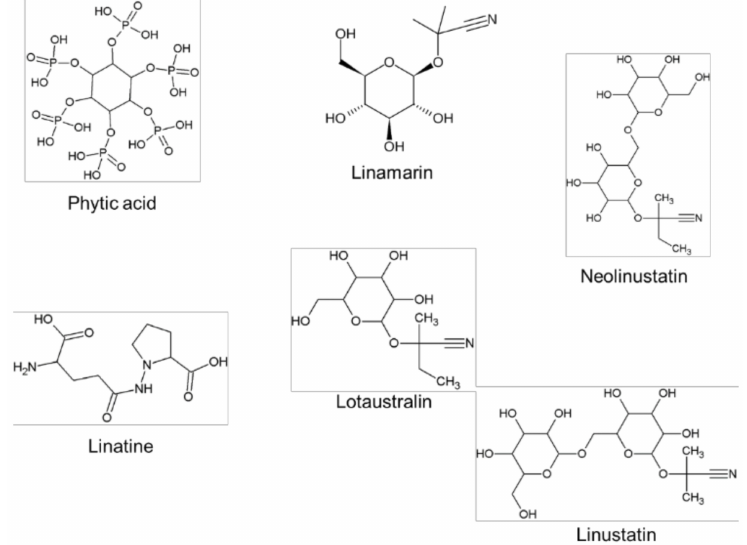
Figure 5. Chemical structures of flaxseed antinutritional